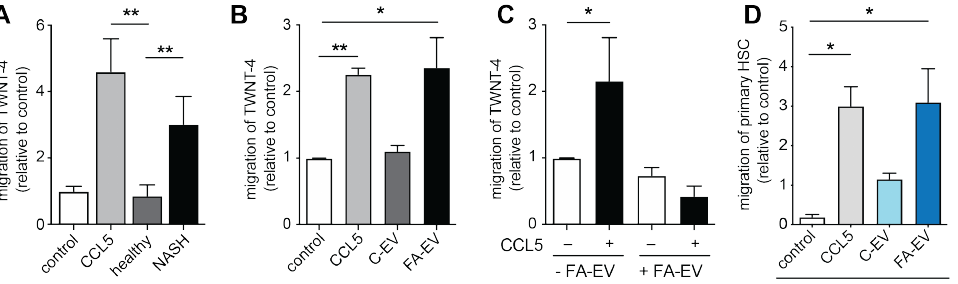
Figure 2. Migration of TWNT4 and primary stellate cells towards patient sera and EVs released from HepG2 cells. Chemotaxis of TWNT4 cells towards CCL5 or ( A ) sera from individuals with or without MAFLD, or ( B ) towards EVs harvested from HepG2 under resting conditions (C-EVs) or after fatty acid treatment for 24 h (FA-EVs). ( C ) Chemotaxis of TWNT4 cells towards CCL5 with or without pre-treatment with FA-EVs for 24 h. ( D ) Chemotaxis of primary human hepatic stellate cells (HSCs) towards C-EVs or FA-EVs (light and dark blue bars, respectively). Five view fields were counted per filter and normalized to the control. * p < 0.05, ** p < 0.01 with one-way ANOVA and Bonferroni post hoc test; mean ± SEM (n = 3).